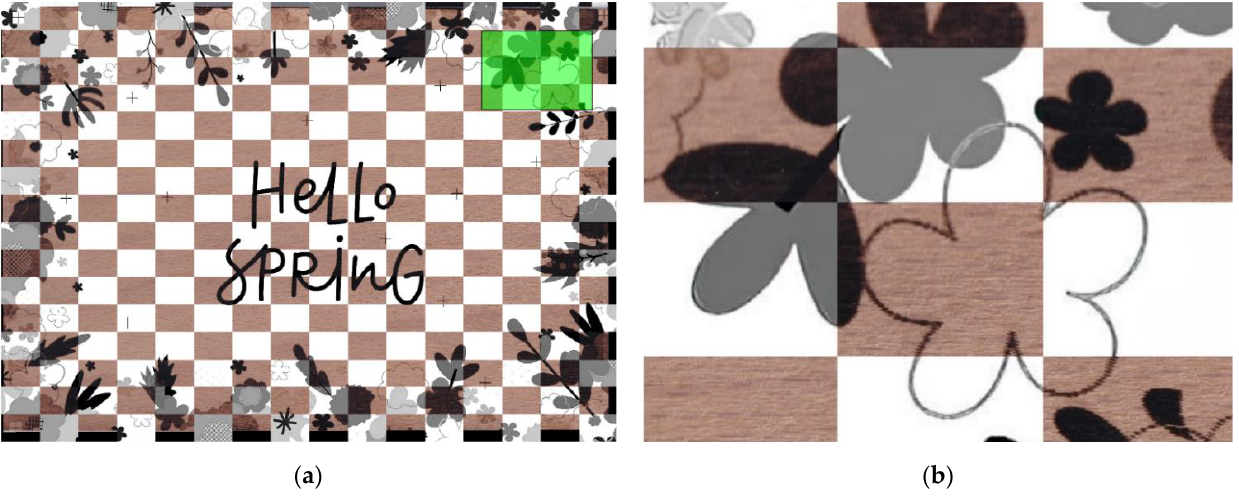
Figure 7. Scanned and source image comparison method: ( a ) Checkerboard method; ( b ) Zoomed area.